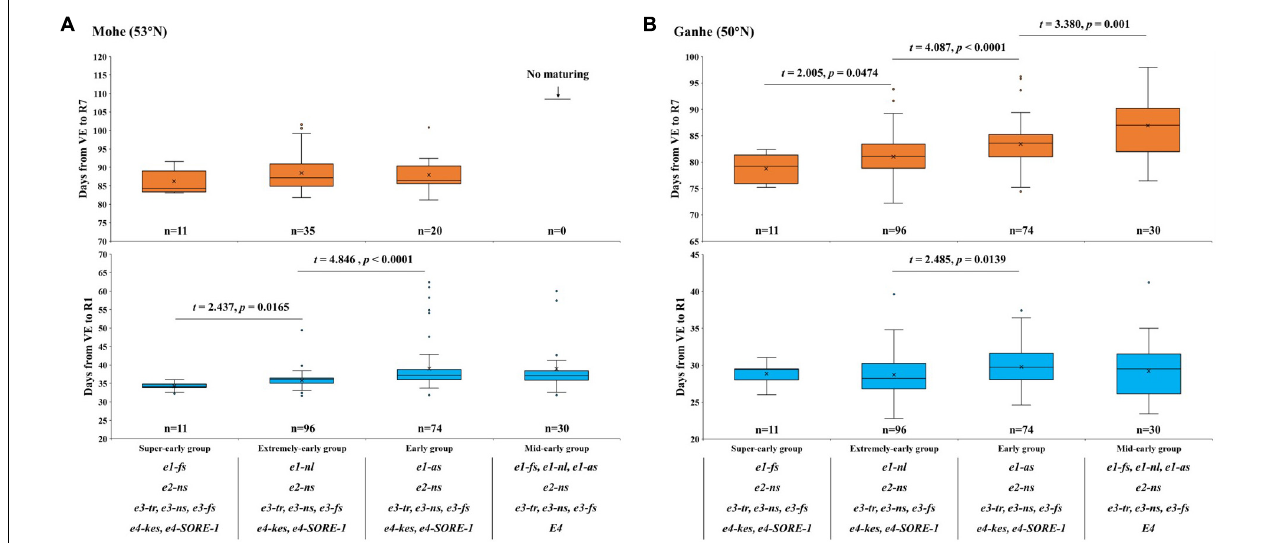
FIGURE 4 | Flowering time (days from VE to R1) and maturity time (days from VE to R7) of different E allele combinations in (A) Mohe (53 ◦ N) and (B) Ganhe (50 ◦ N). VE, emergence; R1, beginning bloom; R7, beginning maturity. The t value and P value for two-tailed t -test are shown above the box plot.